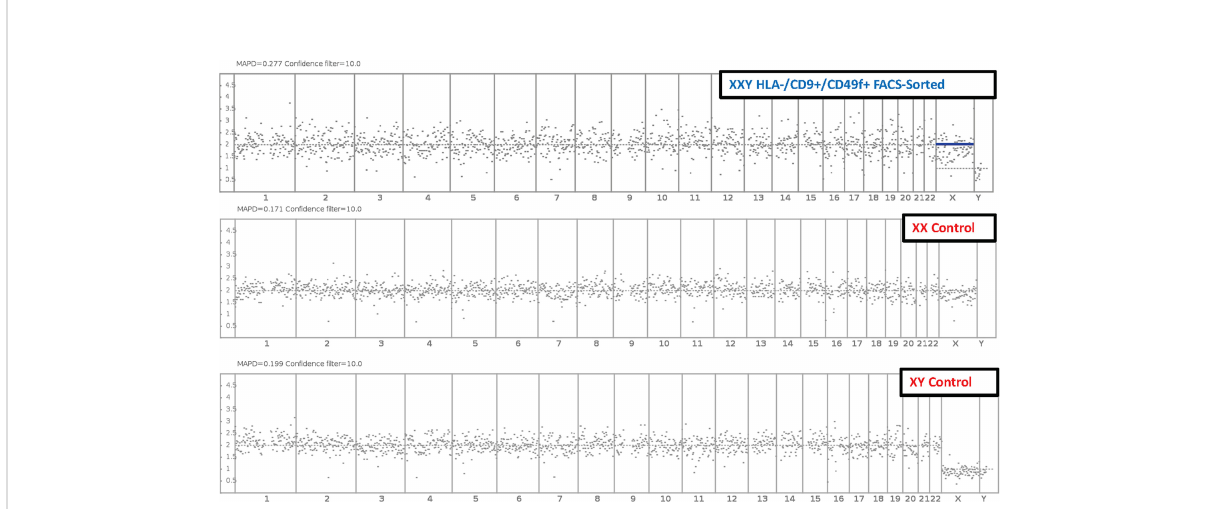
FIGURE 8 Molecular Karyotyping by next-generation sequencing. After 47 days and 6 passages, Klinefelter cells in culture were FAC Sorted for putative SSC markers HLA-/CD9+/CD49f+. Then cells were analyzed with next generation sequencing and compared to XX and XY controls.